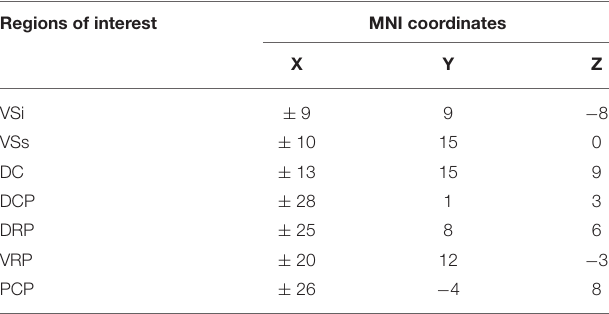
TABLE 1 | The co-ordinates of the regions of